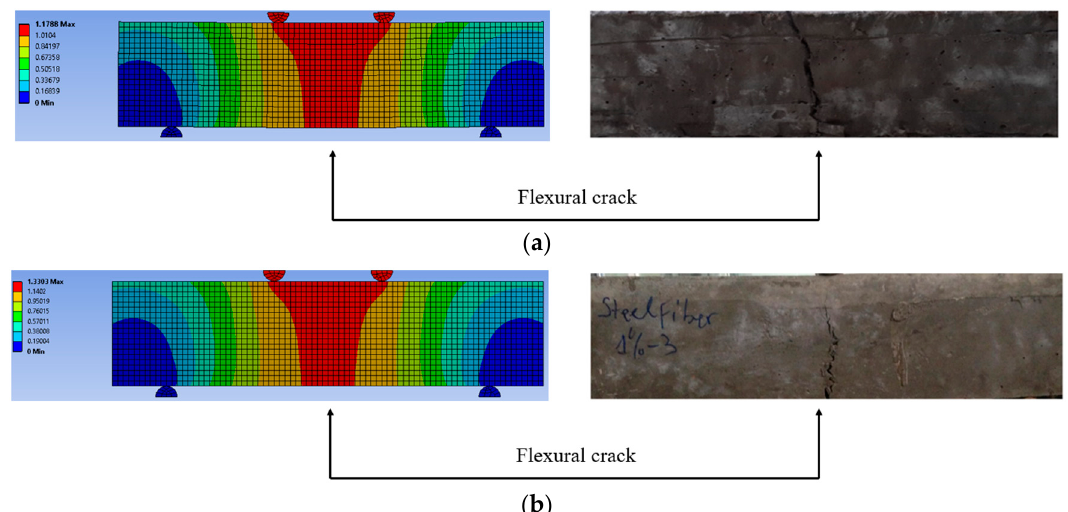
Figure 22. Comparison the load–deflection behavior. ( a ) Specimen H1; ( b ) specimen H2; ( c ) specimen P1; ( d ) specimen P2.